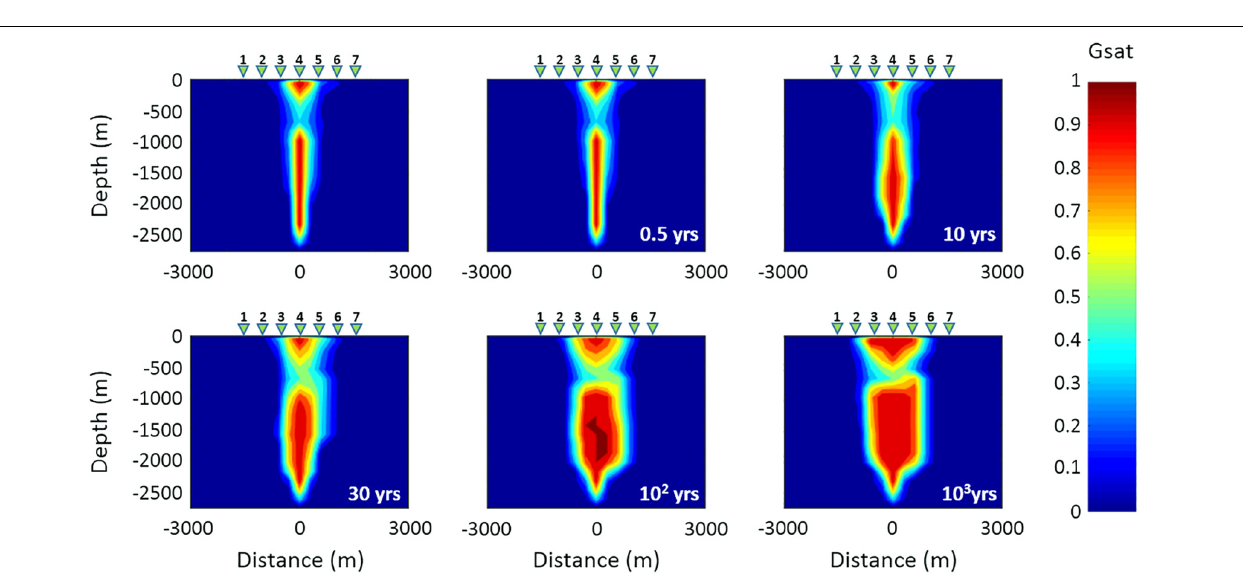
FIGURE 5 | Time evolution of the temperature distribution related to Scenario I in the vertical section along the red line shown in Figure 3 . The first panel of the sequence shows the initial temperature distribution. The green triangles 1–7 indicate the MT stations.